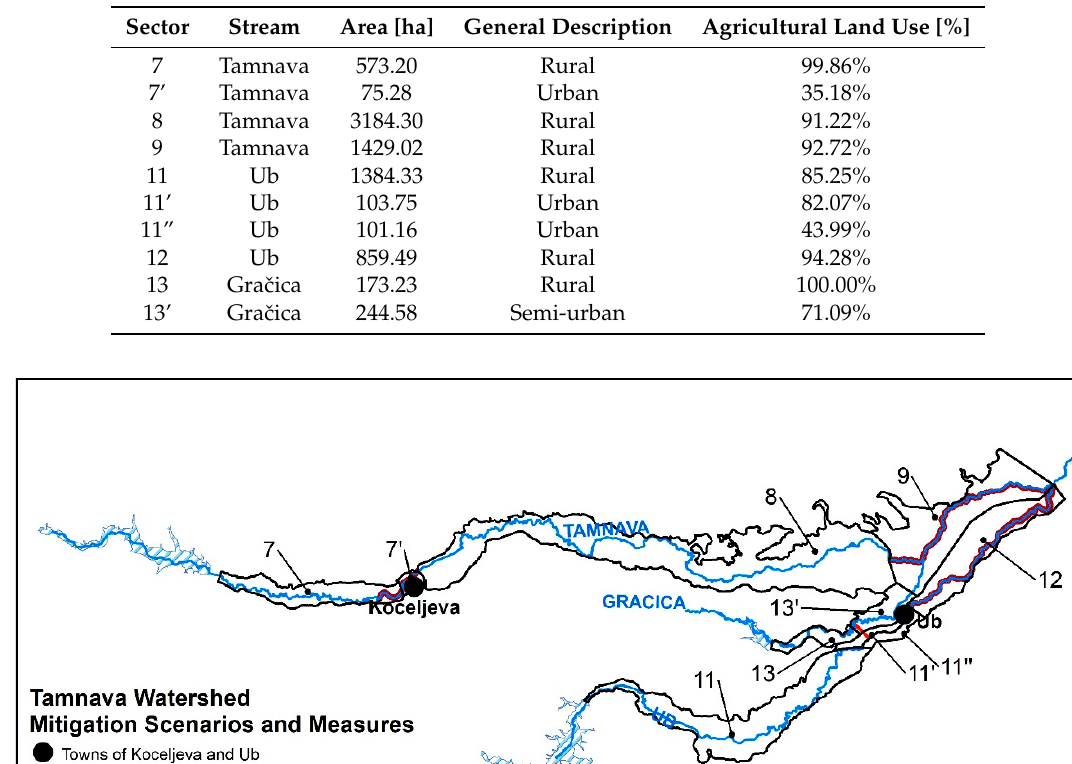
Table 1. River sectors in the study area.